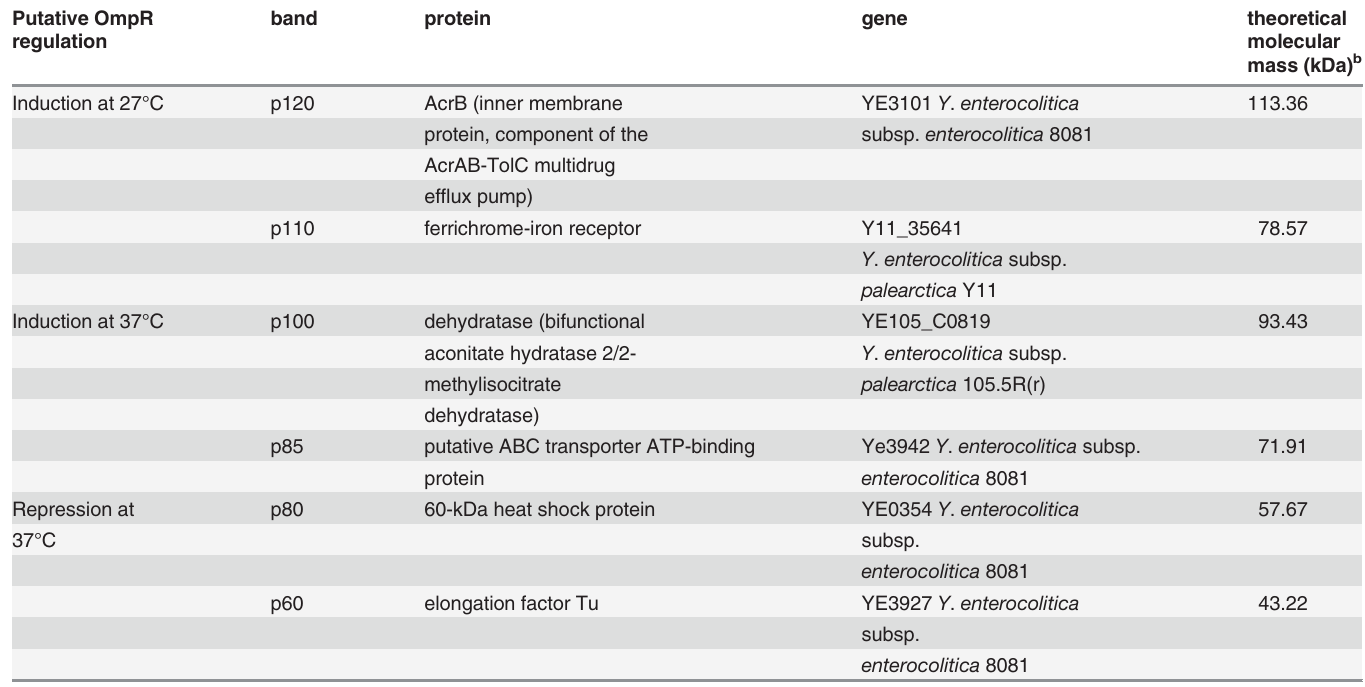
Table 2. Putative OmpR-regulated proteins of Y . enterocolitica Ye9 identified by SDS-PAGE and LC-MS/MS a